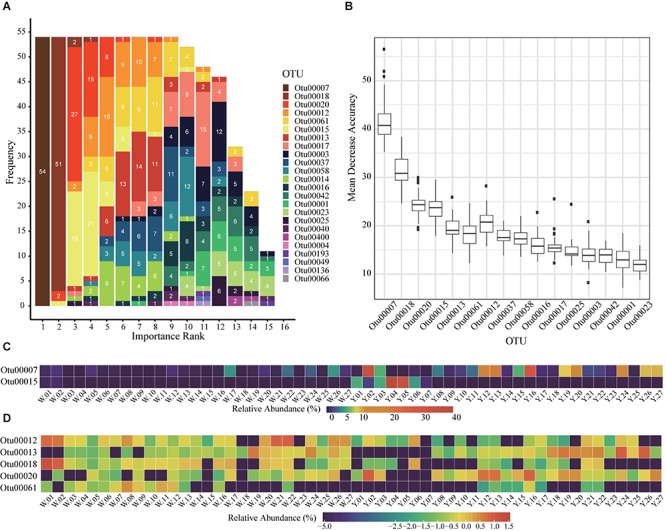
Seven marker OTUs selected with Leave-One-Out Cross Validation (LOOCV). (A) The rank of OTUs in LOOCV with random forest classifier. The labels are all feature OTUs in a total of 54 classifier. The x axis is the rank and the y axis is the frequency of each rank. The number in each bar is the frequency of each OTU in each rank. The OTUs with sum of numbers greater than 50 are identified as marker OTUs. (B) The mean decrease accuracy boxplot of OTUs in the 54 random forest classifiers for LOOCV. The present OTUs are used in more than 10 classifiers. (C,D) The relative abundance of the seven marker OTUs in 54 immature starters. (C) The relative abundances are percentages (x%). (D) The relative abundances are percentages transformed with formula log10 (relative abundance+1e-08).